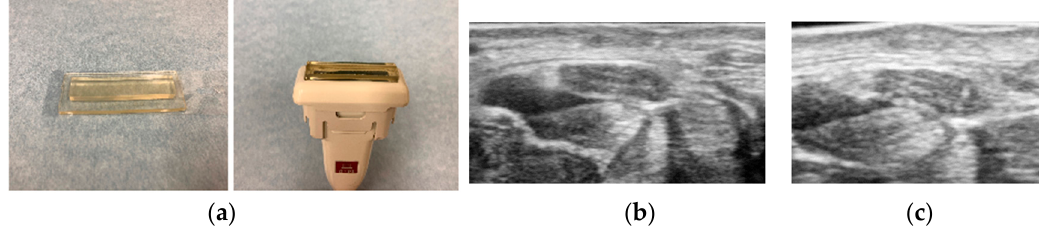
Figure 2. Use of acoustic coupler for the uneven skin surface. ( a ) Acoustic coupler, ( b ) an example image of median nerve without acoustic coupler, ( c ) an example image of median nerve with acoustic coupler. Fascicular pattern can be visualized with the acoustic coupler.